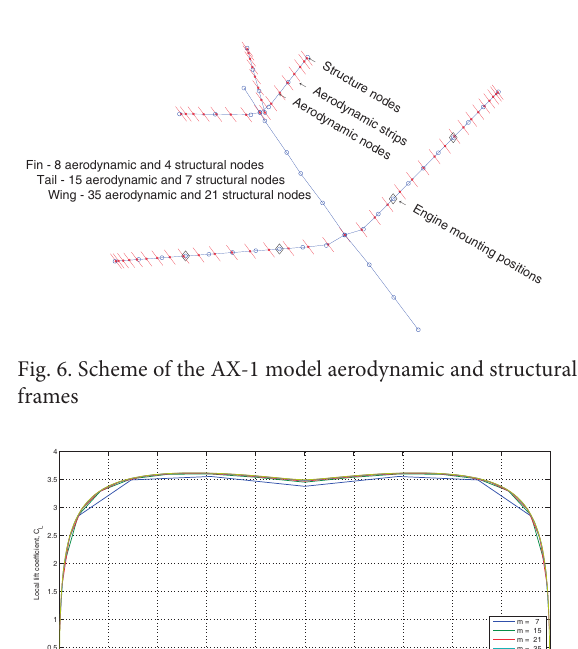
Fig. 9. First 4 mode shapes of the AX-1 model structure